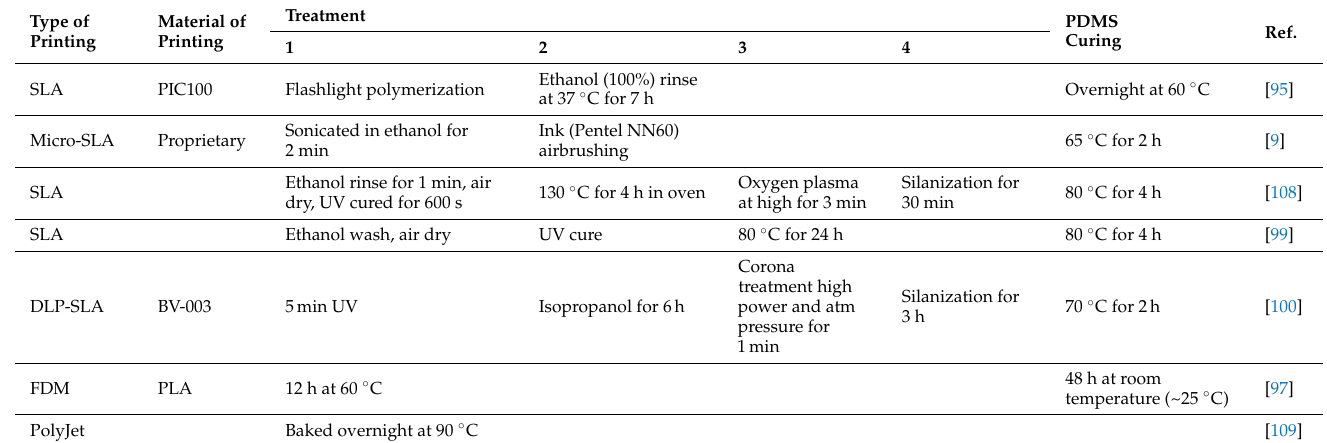
Table 2. The post-treatment process for the printed mold along with the conditions for PDMS